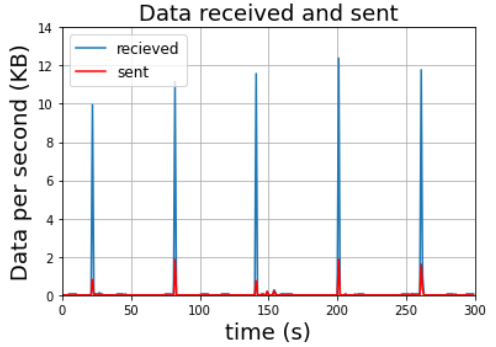
Figure 5. CPU & RAM usage for ChronoEOS.